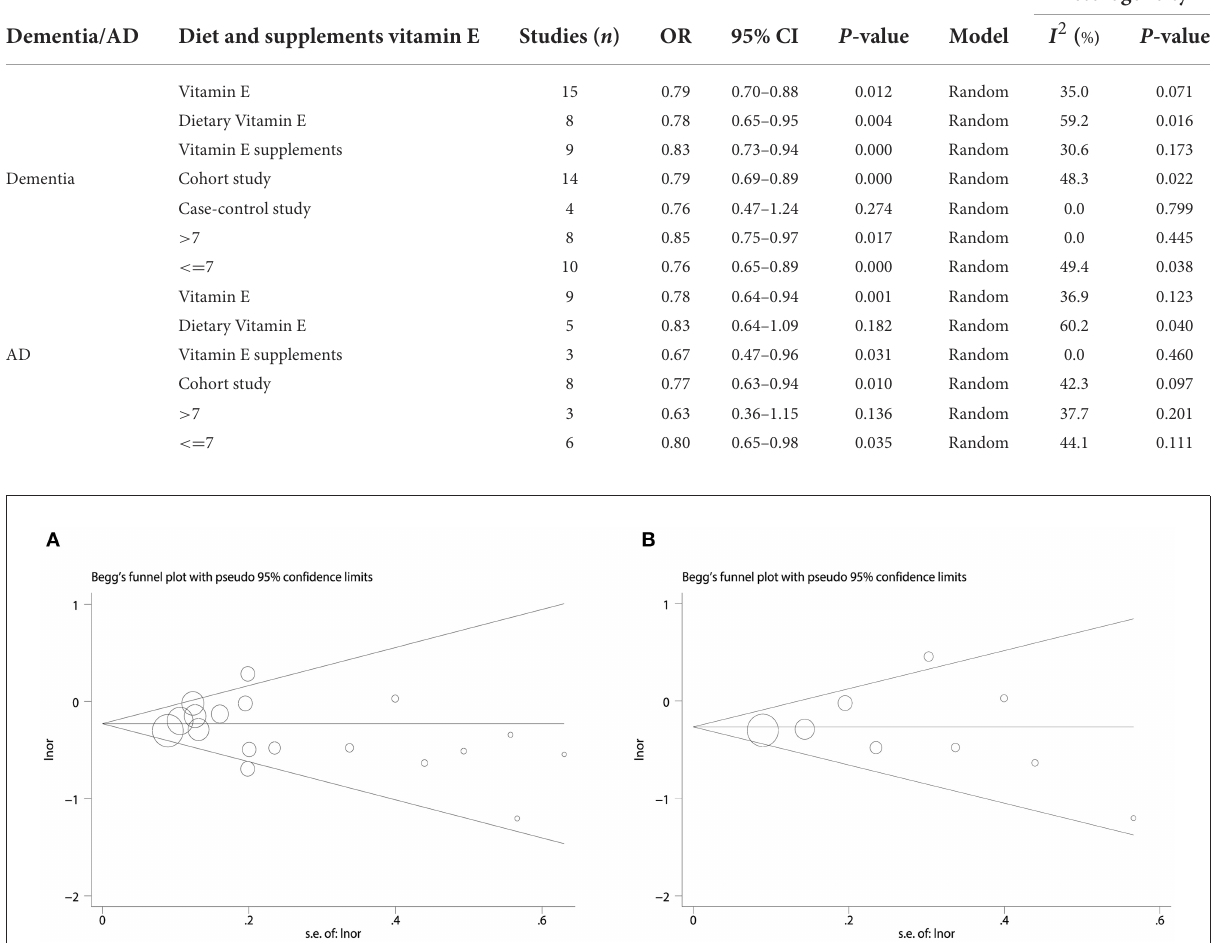
FIGURE4 Publication bias begg’s funnel plot. (A) Funnel plot for combined dietary and supplement outcomes with dementia risk. (B) Funnel plot for combined dietary and supplement outcomes with AD